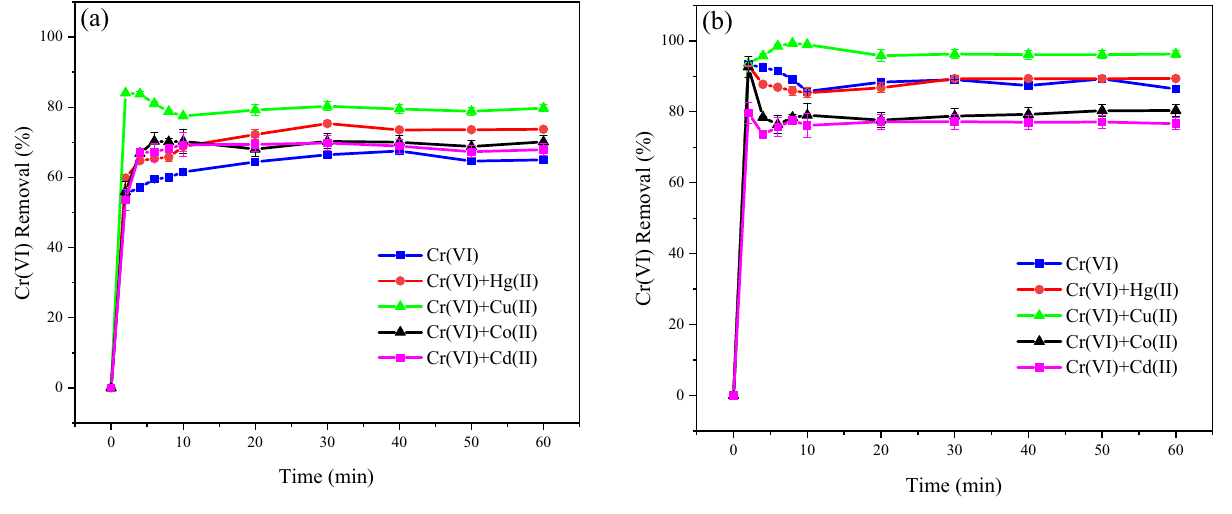
Figure 6. The effects of metallic cation’s presence on the Cr(VI) removal using ( a ) Talc-nZVI/3Sn and ( b ) Talc-nZVI/6Sn (Cr(VI) initial concentration: 80 mg/L, metallic cations initial concentration: 40 mg/L, nanocomposite dosage: 1